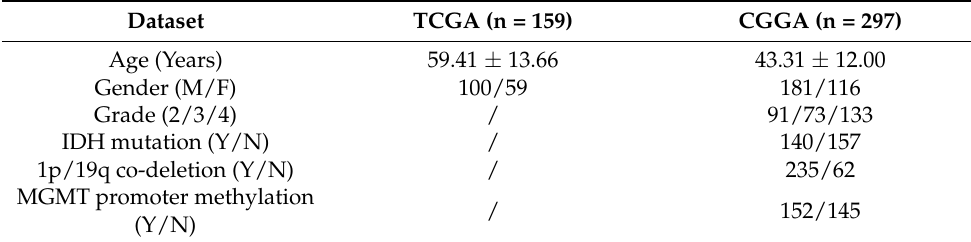
Table 1. Patient clinical information in TCGA and CGGA HGG